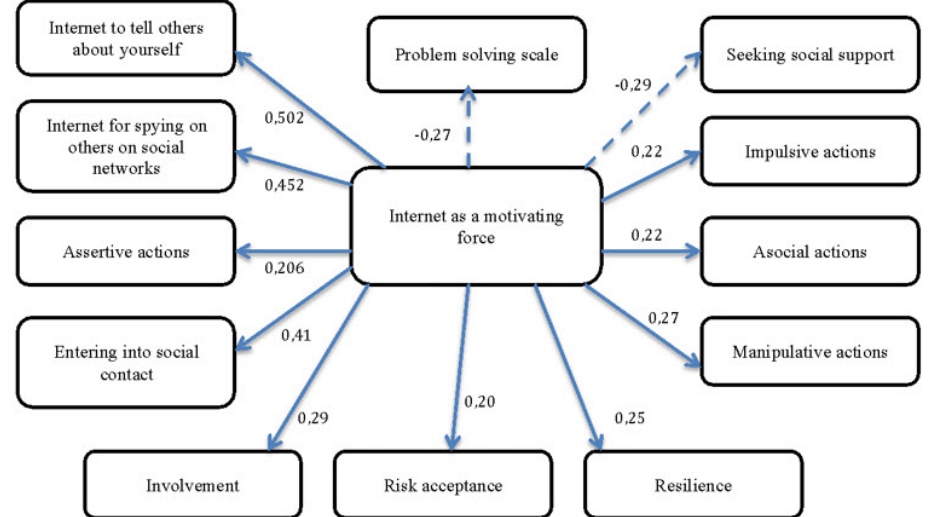
Figure 2. Correlation links with the strategy “Internet as a motivating